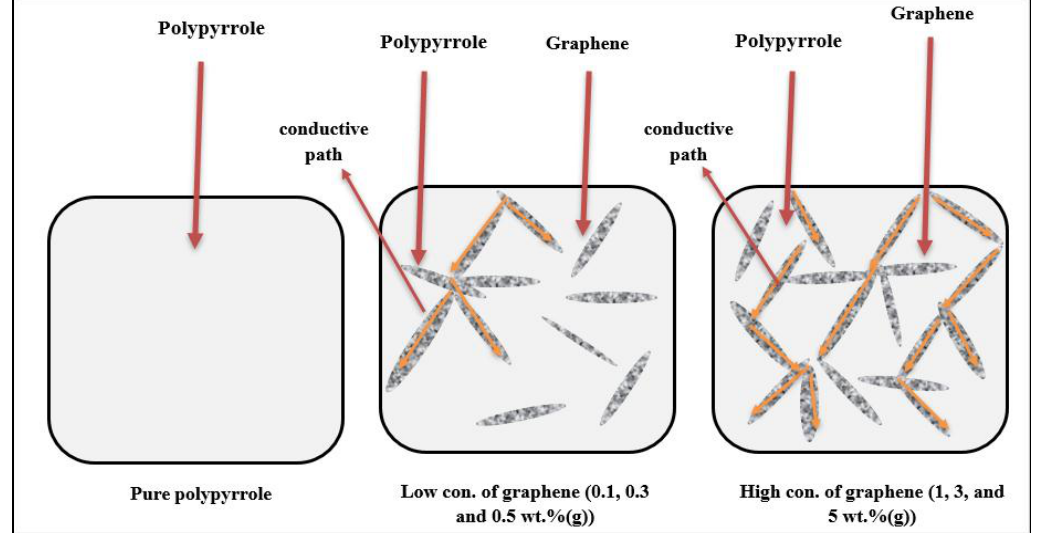
Fig.13: Configuration of GN in PPy